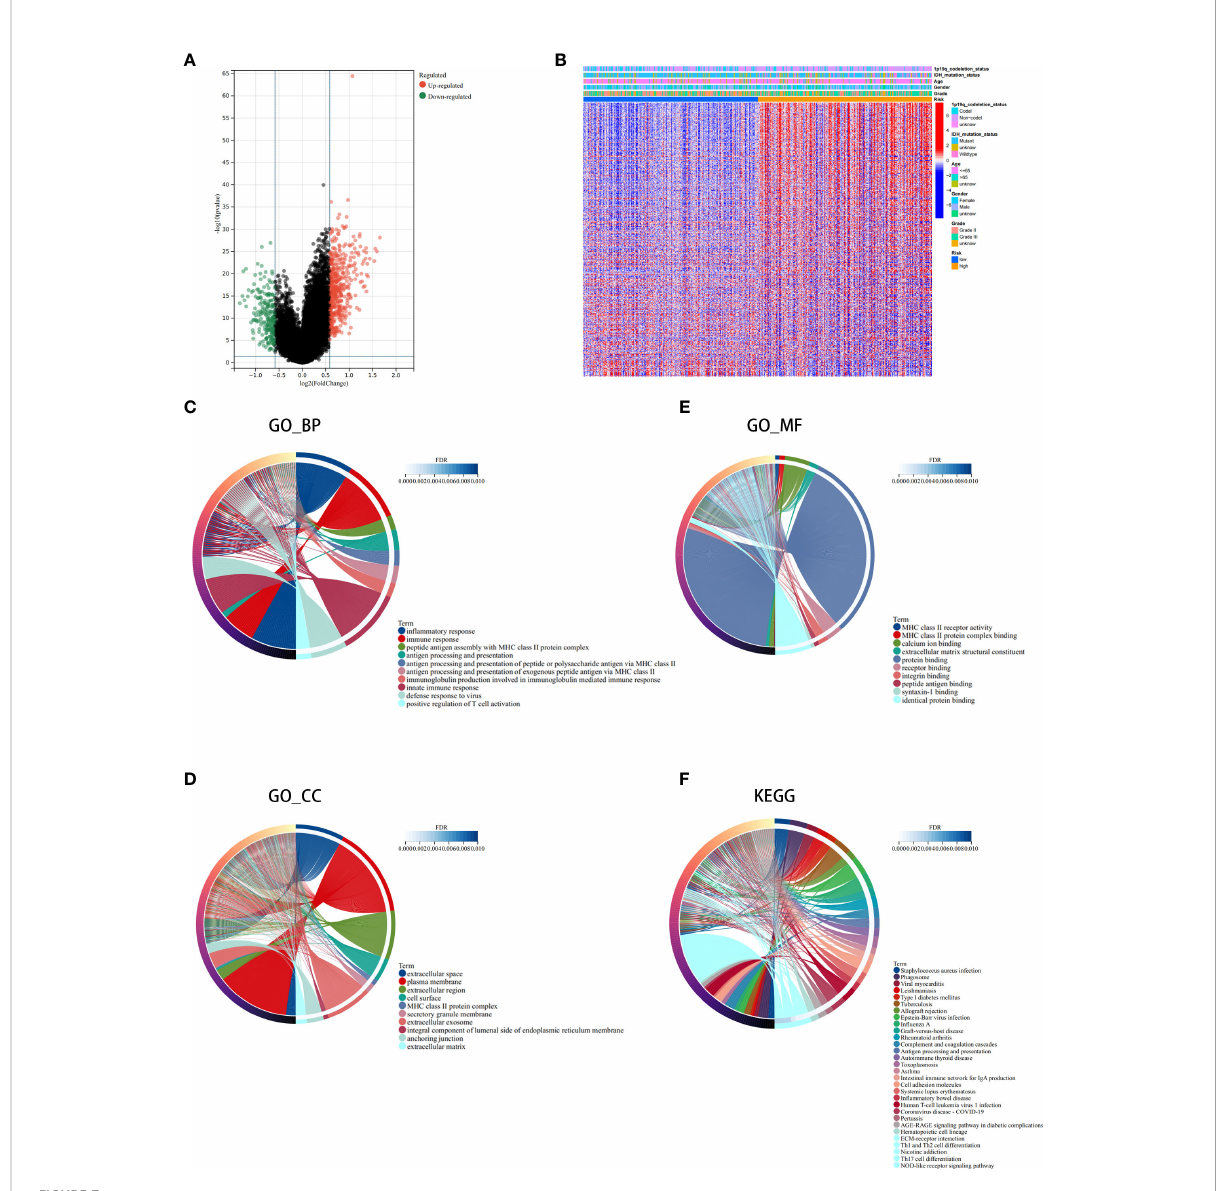
FIGURE 7 Analysis of the differentially expressed genes (DEGs) and functional enrichment analysis in different ICD risk scores. (A) Volcano plot of the distribution of DEGs between the ICD-high and ICD-low risk groups in the TCGA cohort. (B) Heatmap of DEG expression between the ICD- high and ICD-low risk groups. (C – F) GO (C – E) and KEGG (F) enrichment analyses. The outermost circle on the right represents the term on the right, and the inner circle on the right represents the FDR of the corresponding